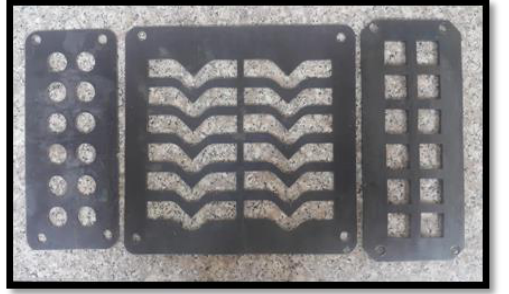
Figure 1: Custom made metal molds. After polymerization, specimens were removed from the molds carefully and excess flush was trimmed with a scalpel. Scanning Electron Microscope (SEM) had been done for some samples in order to insure the